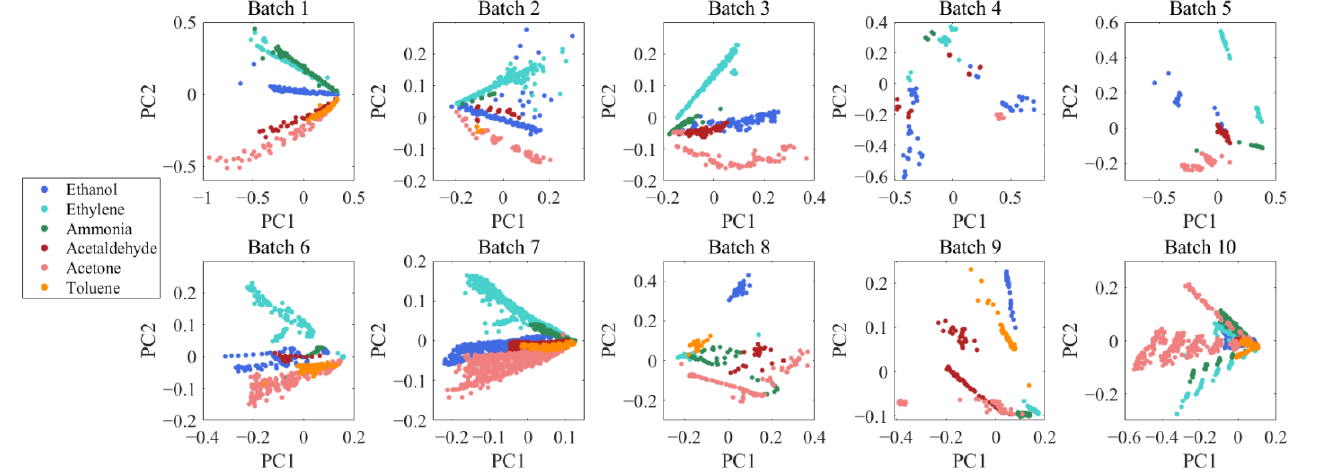
Figure 3. Principal component analysis of ten batches of data. The drift of the data over time batches is evident from the graphs.